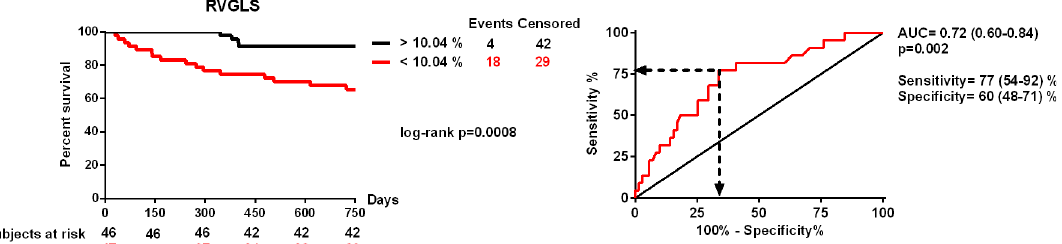
Fig 1. Receiver operating characteristics analysis and Kaplan-Meyer survival curves of patients with right ventricular global longitudinal strain below and above